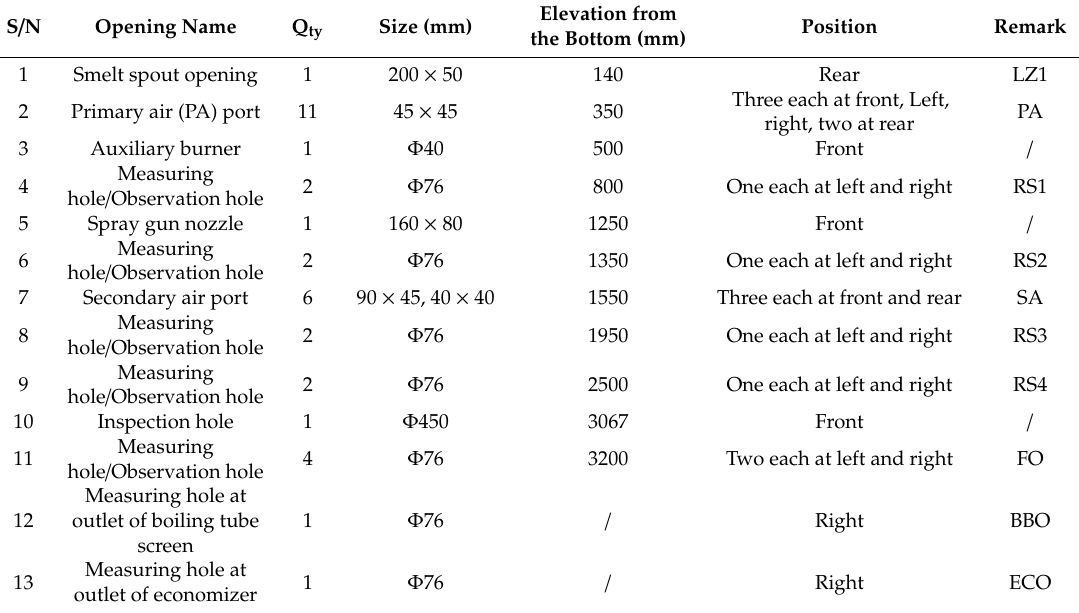
Table 3. Incinerators measure hole and doors and other opening sizes and